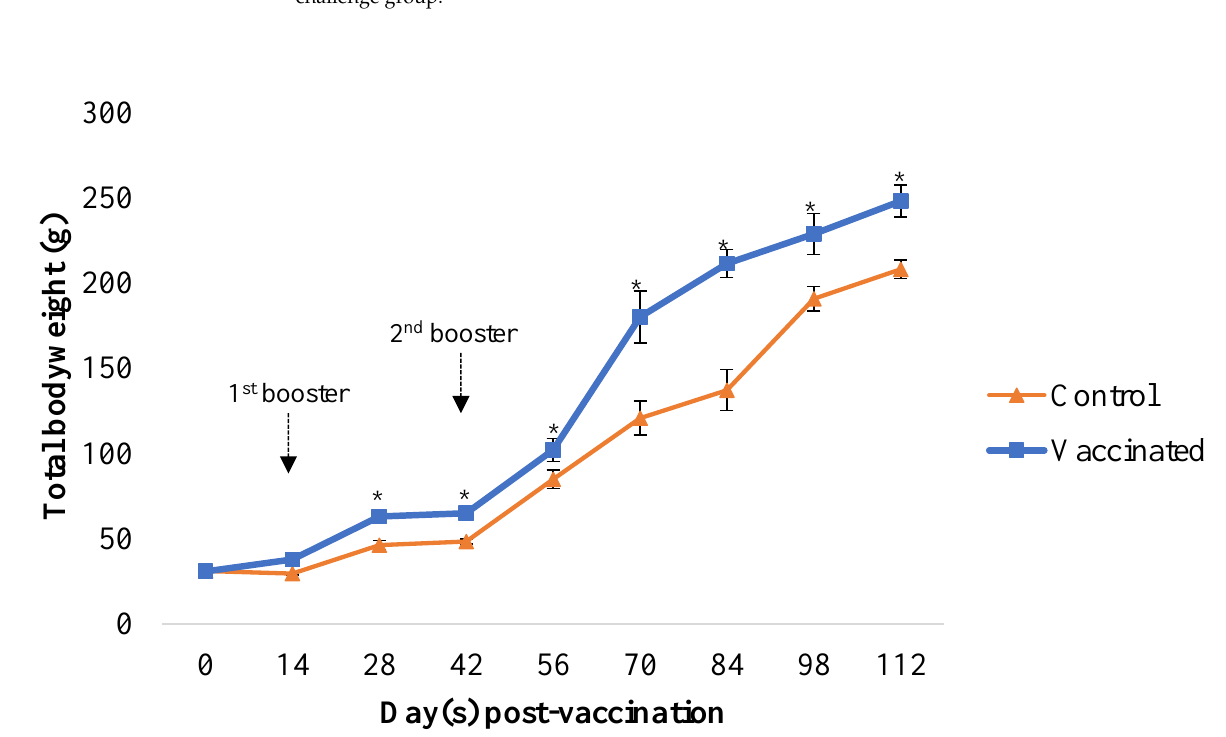
Figure 6. Farm hybrid grouper, Epinephelus fuscoguttus × Epinephelus lanceolatus body weight measured every two weeks for four months. Averaged values of the measurements were used to determine the mean bodyweight of farm hybrid grouper. Data are the mean ± SD from 15 fish per group at each time point. Asterisks stand for statistically significant differences ( p < 0.05) between groups. Table 5. Hybrid grouper fed with Vibrio harveyi strain VH1 (1 × 10 7 CFU/g feed) at 4% body weight according to the vaccination regime. Fifteen fish were randomly selected from each group every two weeks. Vibrio harveyi strain VH1 feed- ing group showed increased feed efficiencies.